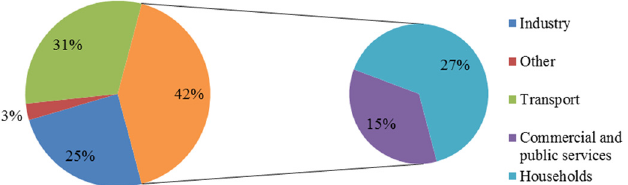
Fig. 1. Final energy consumption in EU by sector in 2017 (Data source: European Environment